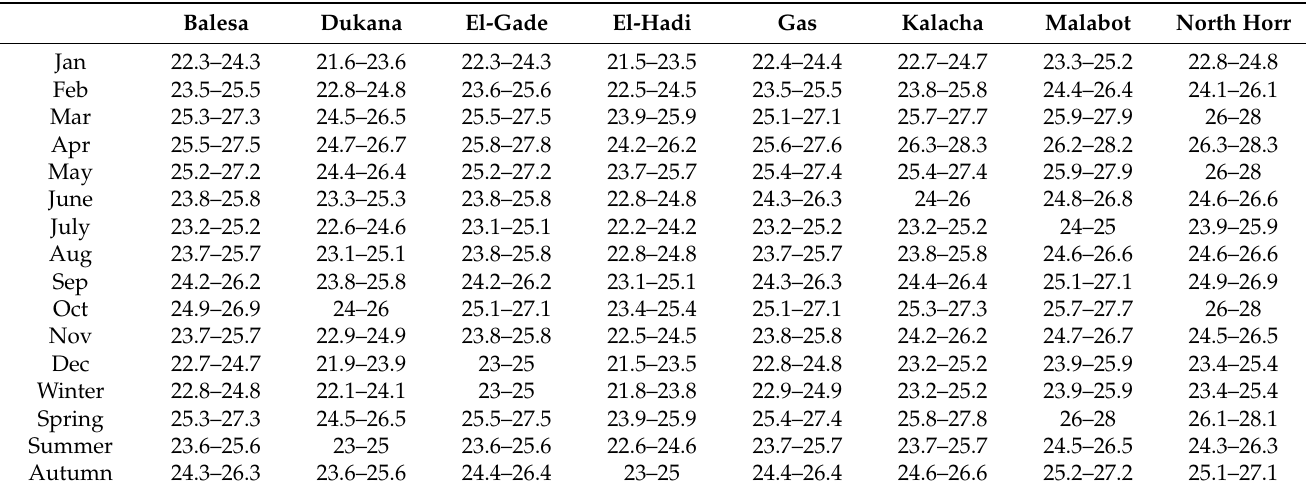
Table 4. Monthly and seasonal 2 ◦ C T MIN ranges centered on the climatological mean and computed for all the eight reference points located in North Horr Sub-County. Values are expressed in ◦